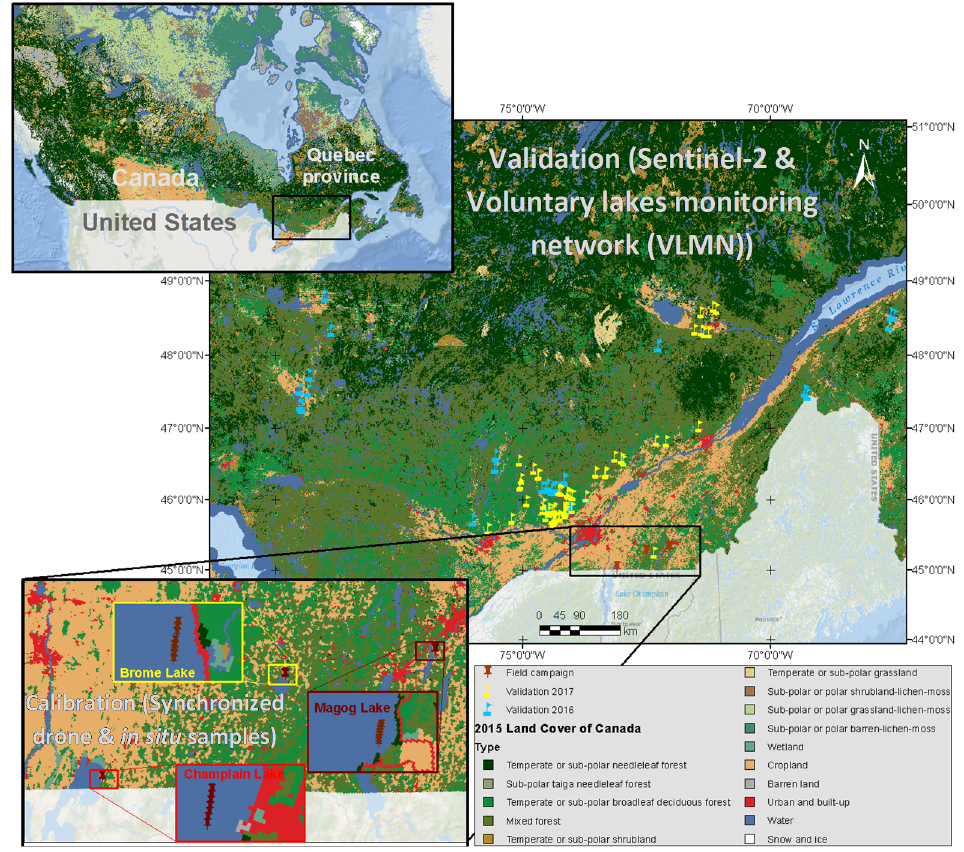
Figure 1. Geographic distribution of sample stations and freshwater bodies used for model calibration and validation. The flags represent data used for the validation collected over 89 inland waterbodies. In the zoomed area, the pushpins represent data used for the calibration collected over Brome, Champlain, and Magog Lakes in the summer of 2017.